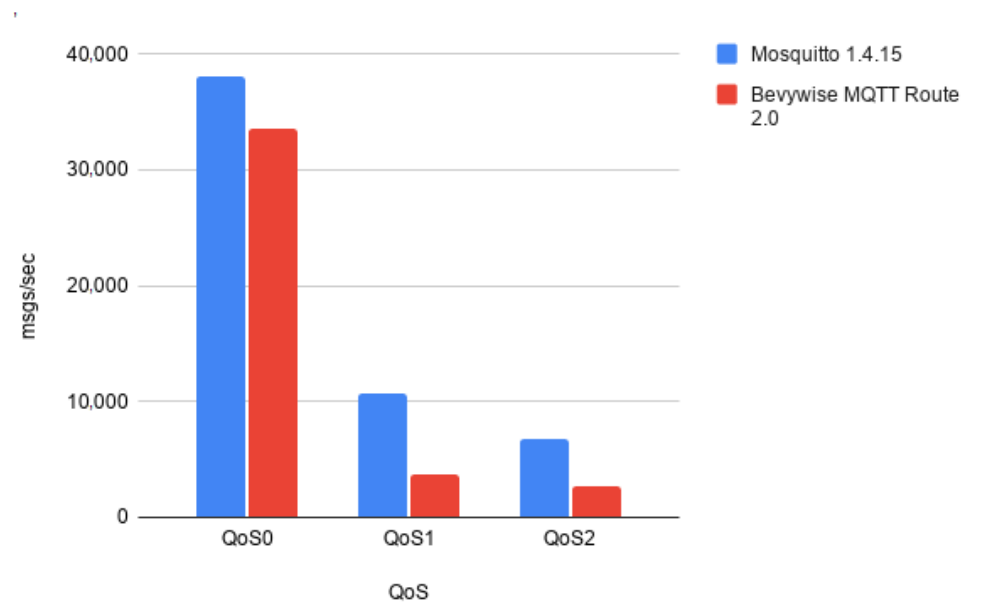
Figure 6. Projected message rate (msgs/sec) of non-scalable brokers at ˜100% process CPU usage in the local evaluation environment.